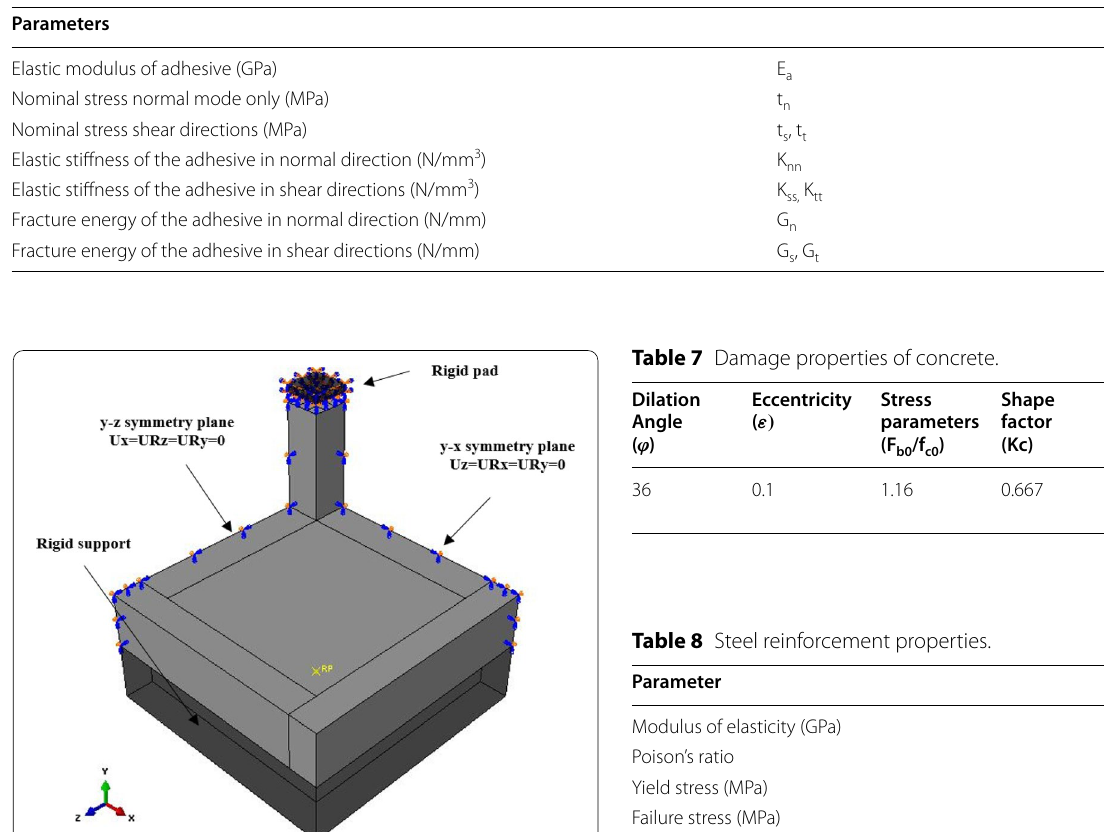
Table 6 Material properties of adhesive.